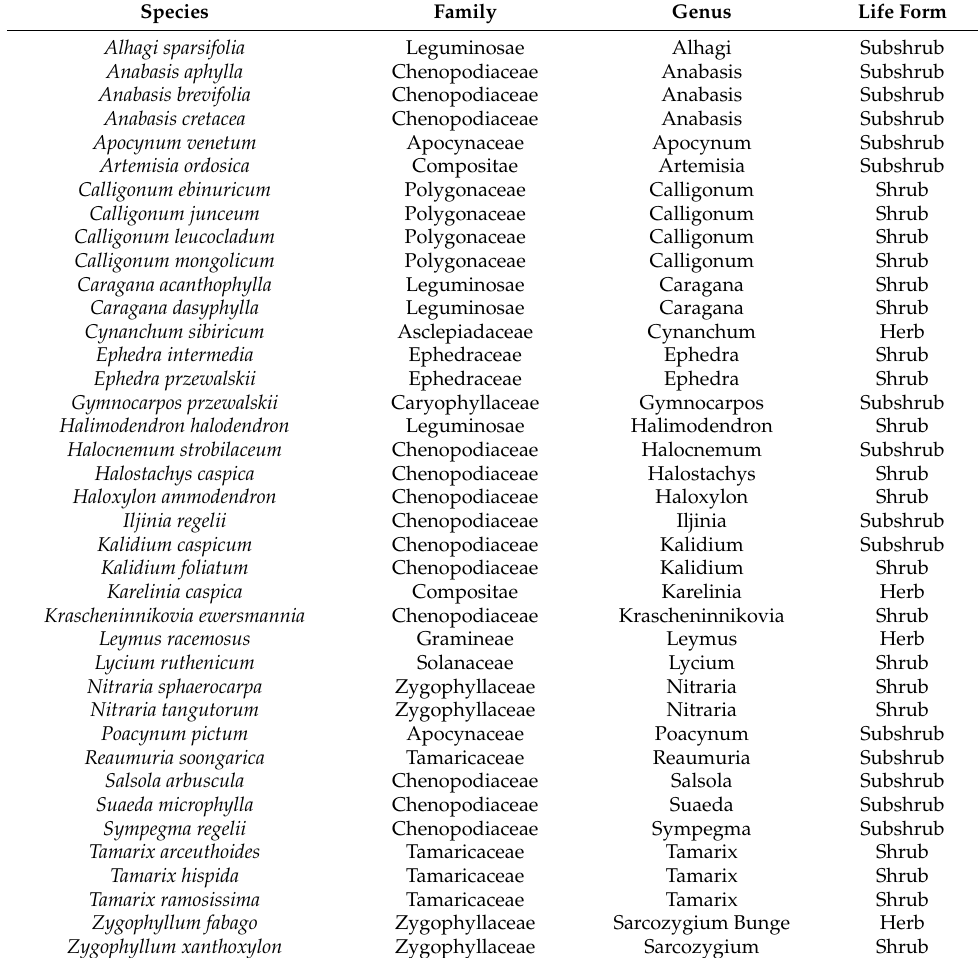
Table 2. Species classification and characteristics of the desert shrub